Question: Express in one sentence what the figure is showing.
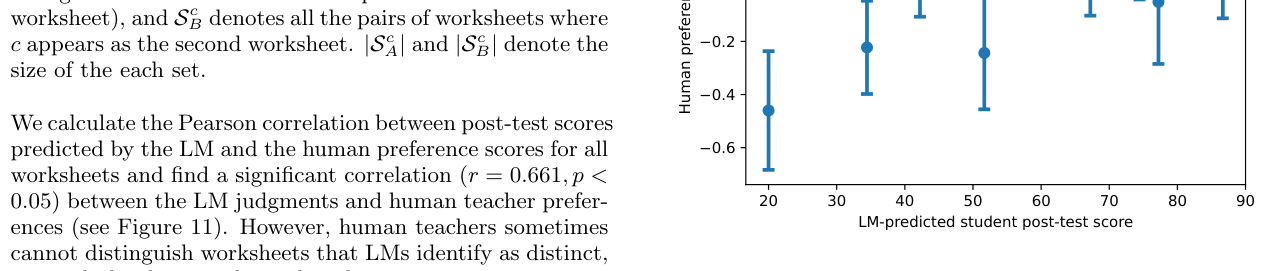
Answer: Evaluations by human teachers (n = 56) show a significant correlation between the LM judgments and human teacher preferences (Pearson r = 0.661, p < 0.05). The error bars are bootstrapped 95% confidence intervals.